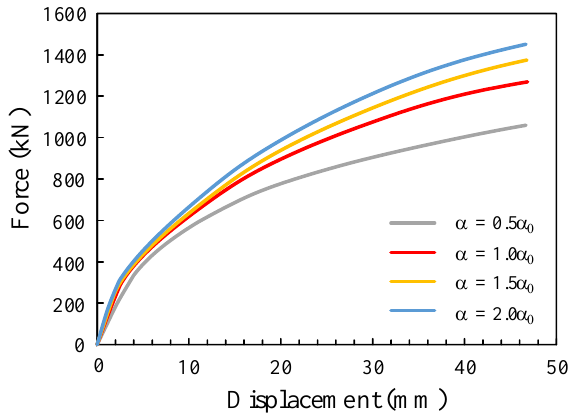
Figure 15. Load–displacement curves for different α Figure 15. Load – displacement curves for different α values. Figure 15. Load – displacement curves for different α values.